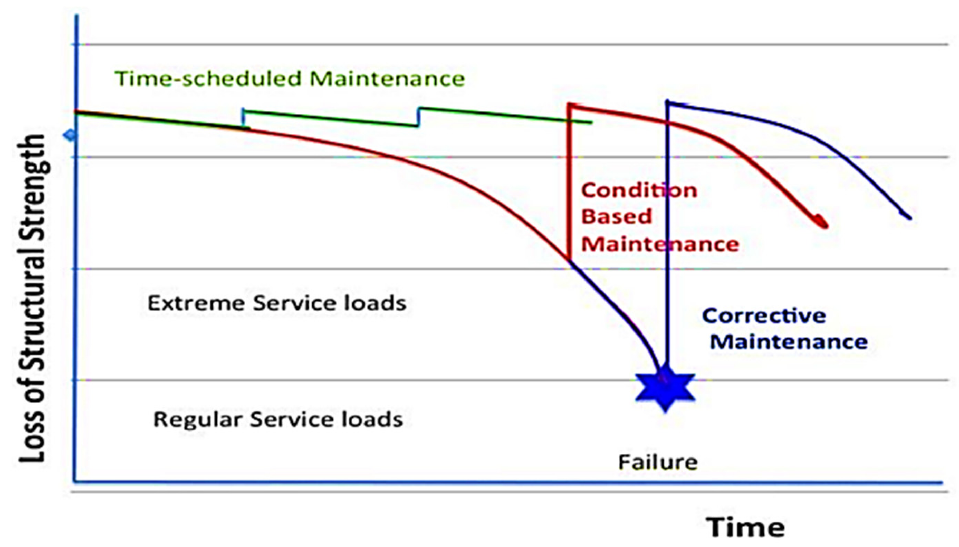
Figure 8. Maintenance strategies with/without SHM [125]. Reprinted under the Creative Commons (CC) License (CC BY 4.0).